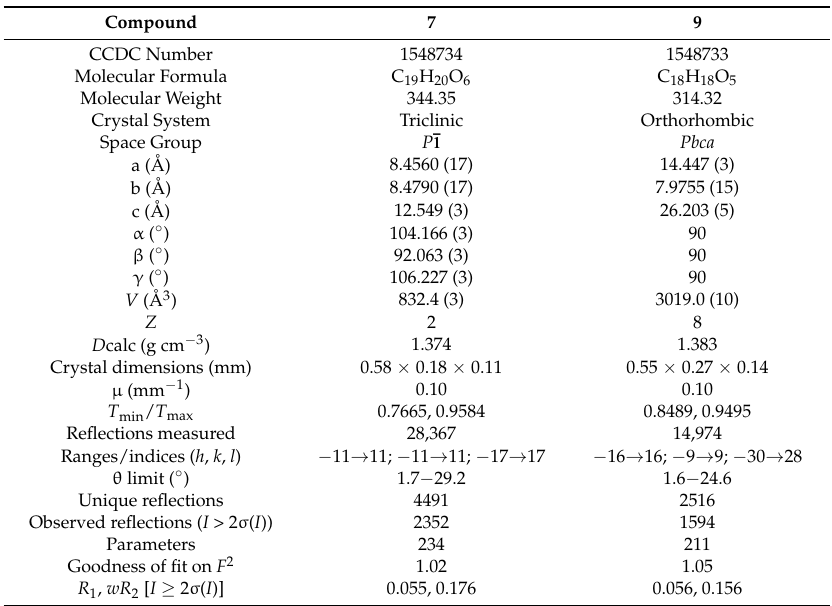
Table 3. Crystal data and parameters for the structure refinement of 7 and 9 .